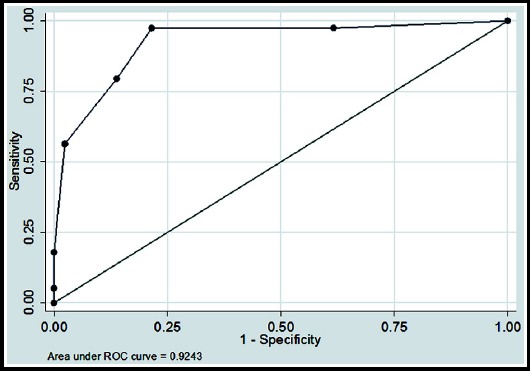
Receiver operation characteristic (ROC) curve of Ranson’s scores in predicting SAP.